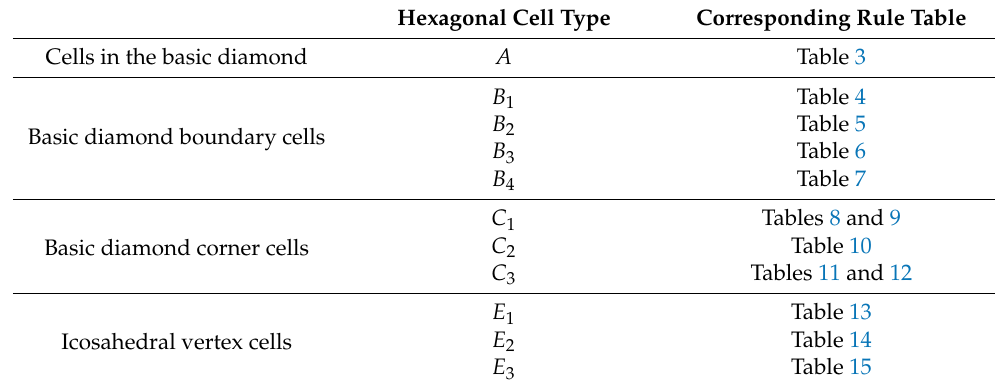
Table 2. GtoG mapping rule index table corresponding to hexagonal cell type.